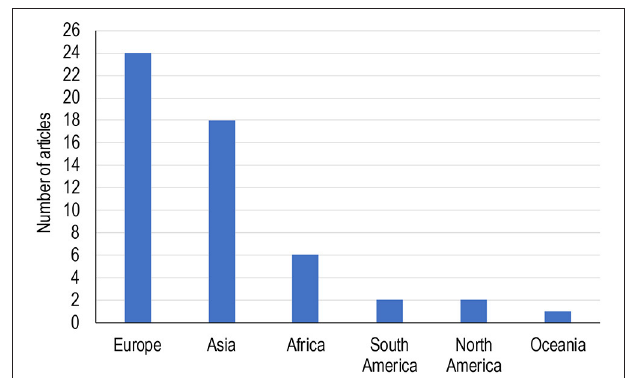
FIGURE 2 | Literature review study locations by